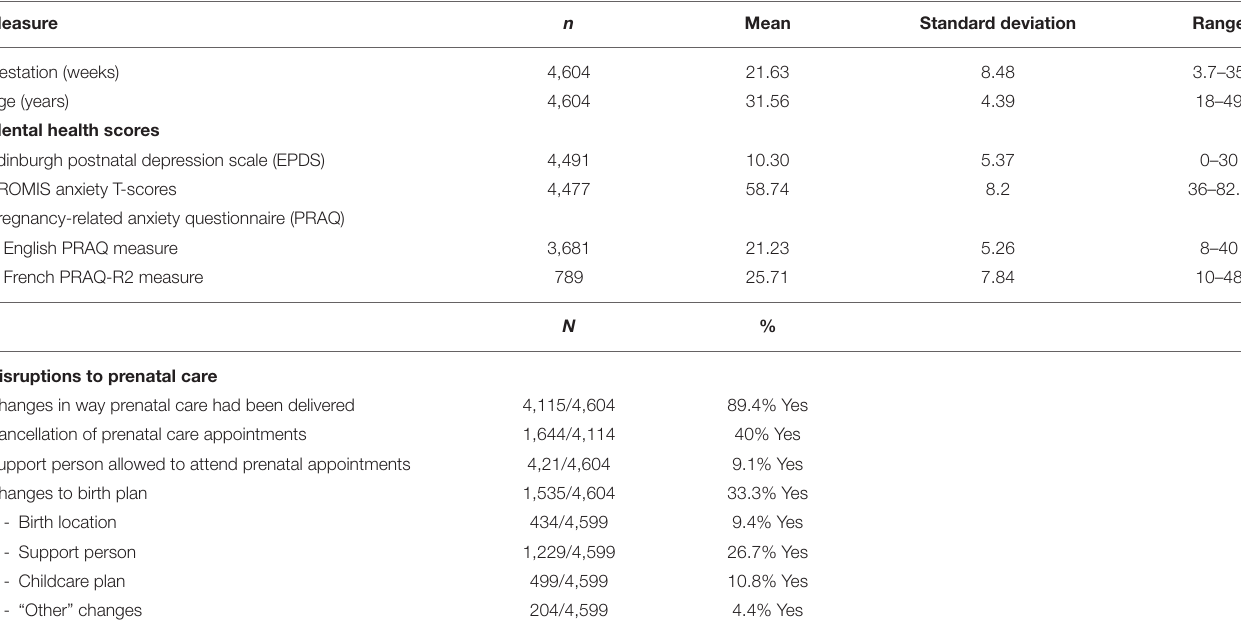
TABLE 1 | Demographics, mental health scores, and disruptions to prenatal care. Measure n Mean Standard deviation